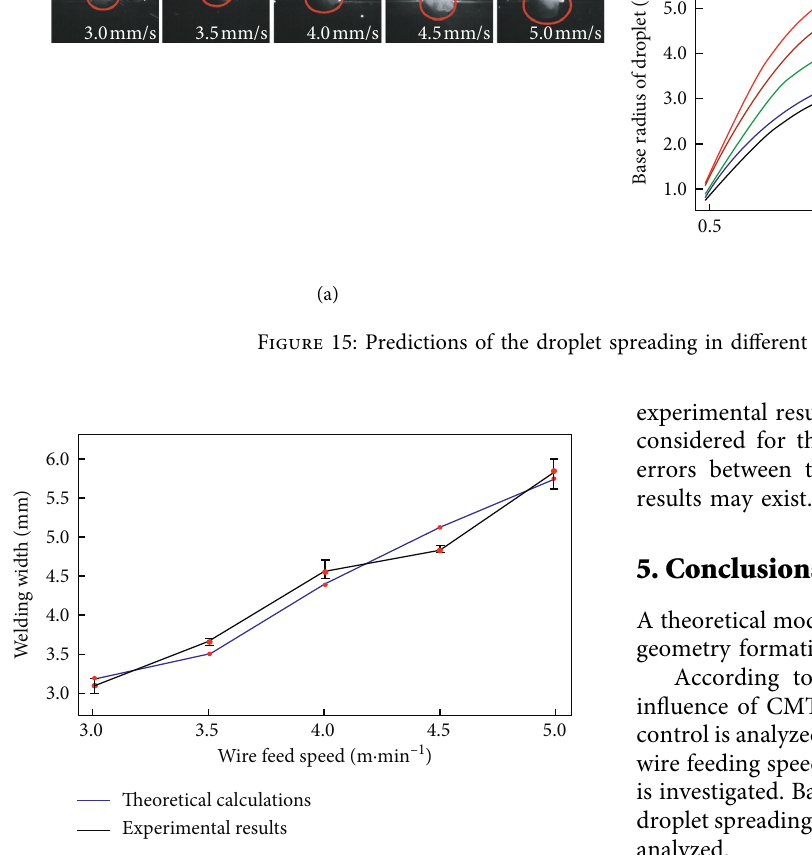
Figure 16: Welding formation in different wire feed